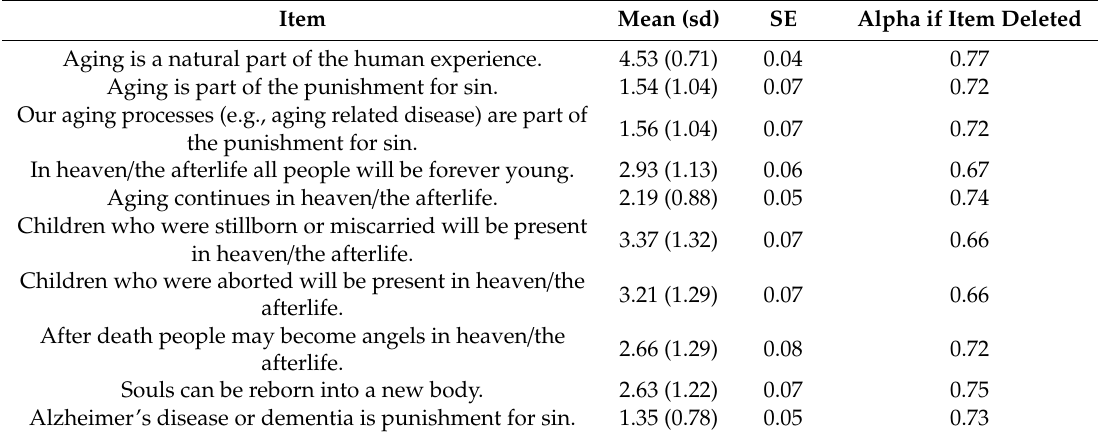
Table 3. Religious beliefs about aging scale * ( n = 286) α = 0.74.